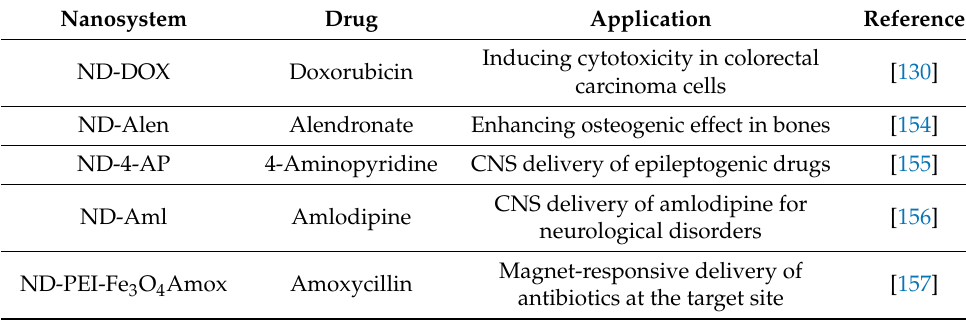
Table 7. Recent advances in nanodiamond-based drug